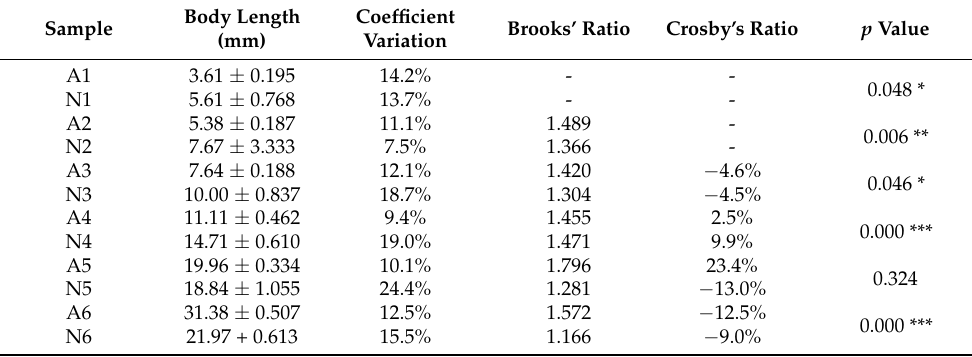
Table A1. The body lengths of L. xylina larvae fed on SAC and